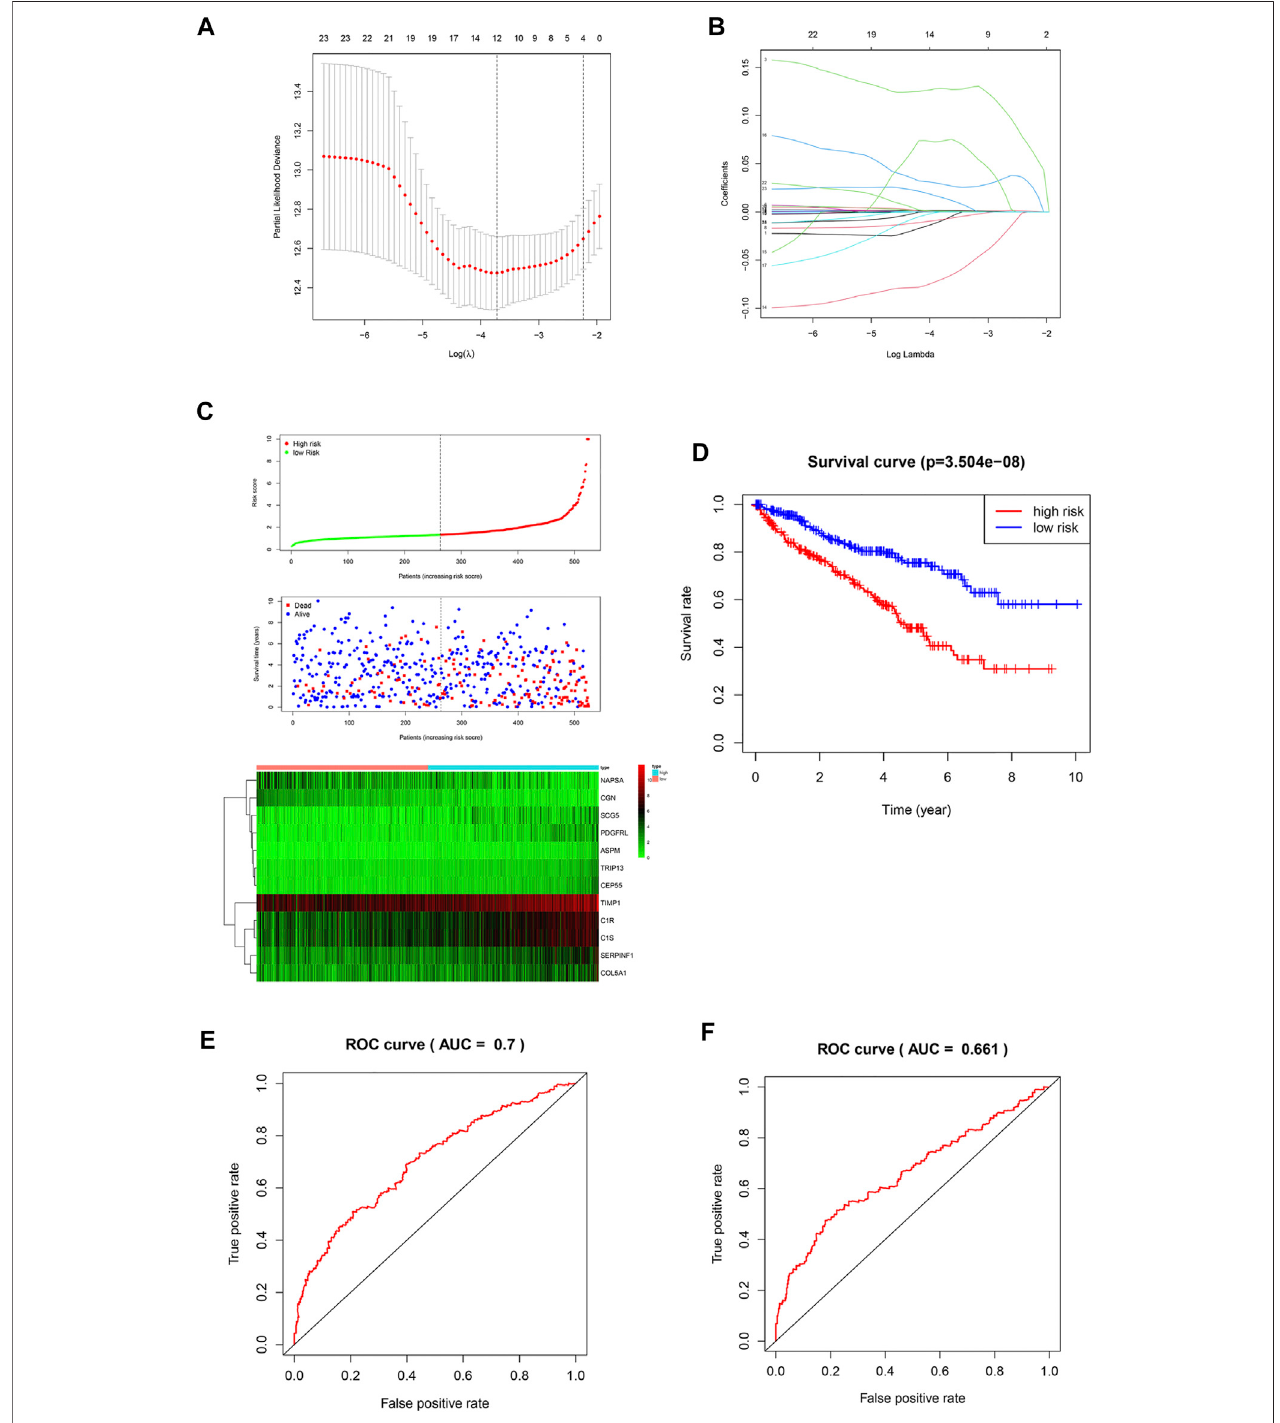
FIGURE 3 | Construction of a prognostic signature. (A,B) LASSO analysis with a minimum lambda value. (C) Risk score, patient survival status distribution and expressionheatmapsfor12metastasis-associatedprognosticrisksignatures. (D) Kaplan-Meiercurvesofthelow-andhigh-riskgroups( p < 0.001). (E,F) ROCcurvefor 3- and 5-year survival predictions in patients with ccRCC based on the risk score.